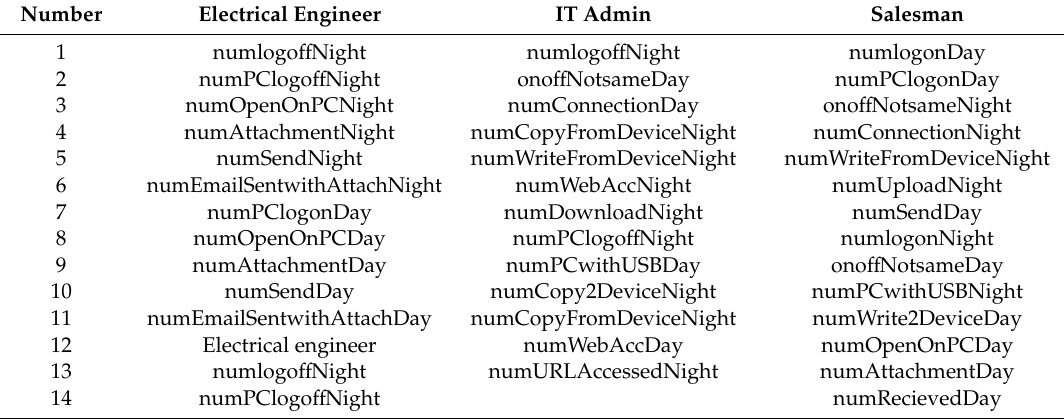
Table 5. Selected variables for each